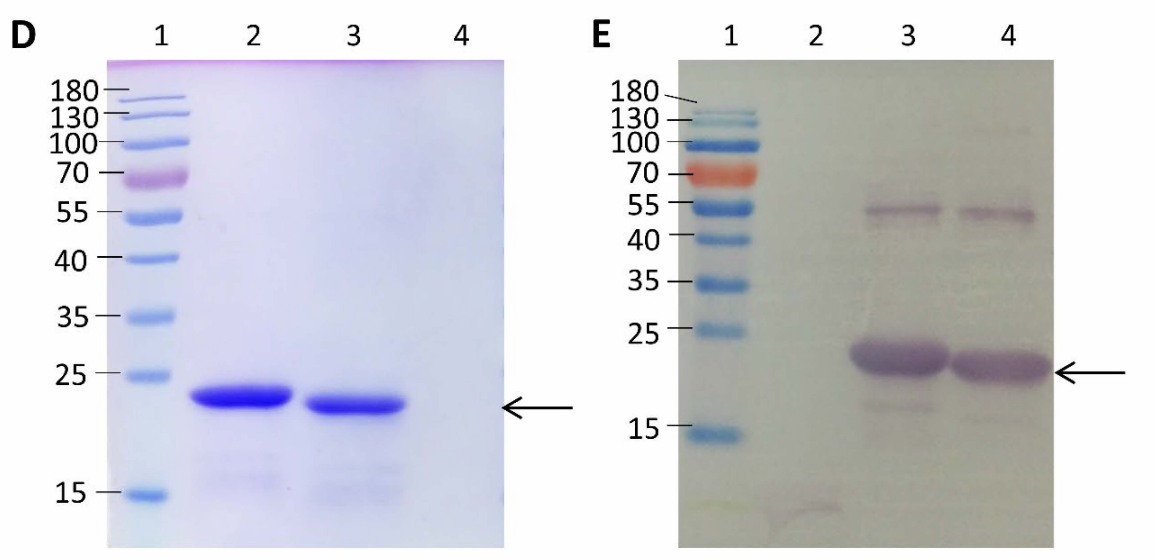
Figure 1. Expression of recombinant Plasmodium knowlesi apical membrane antigen 1-domain II (PkAMA-1-DII). ( A ) Schematic structure of PkAMA-1, which consists of signal peptide (SP), ectodomain [including domain I (D-I), domain II (D-II), and domain III (D-III)], transmembrane region (TM) and cytoplasmic region (CR). The amino acid differences between PkAMA-1-A1-H.1, PkAMA-1-DII-P and PkAMA-1-DII-B were highlighted (positions 296 and 359). ( B ) Visualisation of the Malaysian Borneo PkAMA-1-DII (PkAMA-1-DII-B) expression via SDS-PAGE. ( C ) Visualisation of the Peninsular Malaysia PkAMA-1-DII (PkAMA-1-DII-P) expression via SDS-PAGE. In both ( B ) and ( C ), lane 1: protein marker (10–180 kDa); lanes 2, 4, 6, and 8: PkAMA-1-DII protein expression